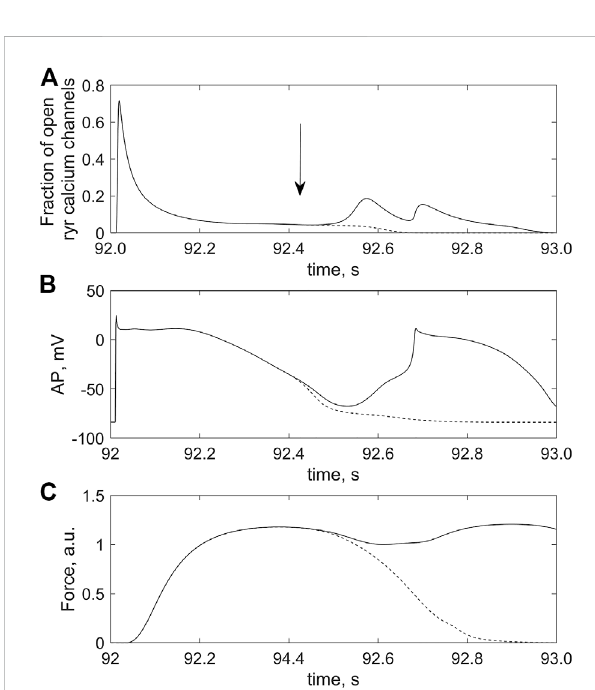
FIGURE 12 Effect ofXb-CaTnCcooperativity on theoccurrence oftriggered activity in the cardiomyocyte overloaded with calcium by the twofold increase in i CaL conductance. The cardiomyocyte is coupled with 2 fi broblasts in model 2 ; ɡ gap =2.0 nS. (A) fractionofRyRcalcium channelsopened; (B) actionpotential( AP ); (C) forcegenerated( Force ) after 96 s of regular stimulation with the rate of 1 Hz. The solid and dashed lines are used for two simulations (see text for details of the numerical